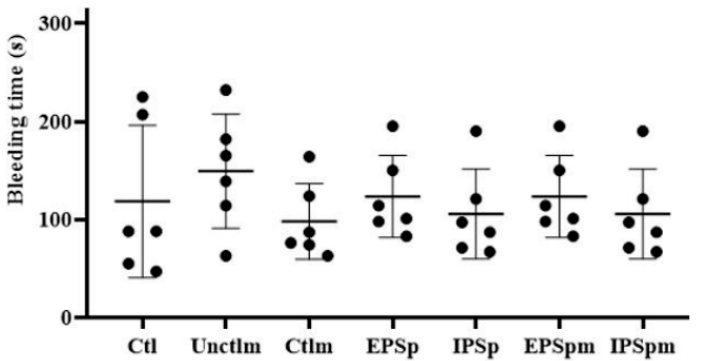
Figure 5. The effects of Cs-4 EPSp, IPSp, and their gut bacterial metabolites on bleeding time in C57BL/6J mice. Ctl: phosphate buffered saline; Unctlm: fecal fermentation basal medium before fecal fermentation; Ctlm: fecal fermentation basal medium after fecal fermentation; EPSp: purified Cs-4 exopolysaccharides, IPSp: purified Cs-4 intracellular polysaccharides. EPSpm: EPSp after fecal fermentation; IPSpm: IPSp after fecal fermentation. Each black dot represents a mouse. Data are presented as mean ± standard deviation, n = 6. p < 0.05, ANOVA.